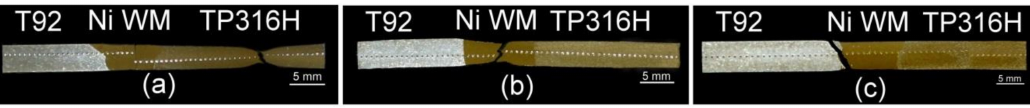
Figure 11. Photo-macrographs of broken tensile specimens’ counterparts showing different failure locations after room-temperature tensile tests of T92/TP316H weldments in their individual material states: “QT PWHT” ( a ); “QT PWHT + 620 ◦ C/500 h” ( b ); “QT PWHT + 620 ◦ C/2500 h” ( c